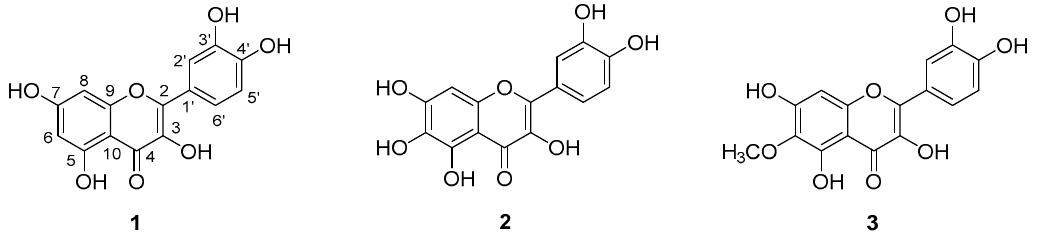
Figure 2. Structures of ( 1 ) quercetin, ( 2 ) quercetagetin and ( 3 ) patuletin.